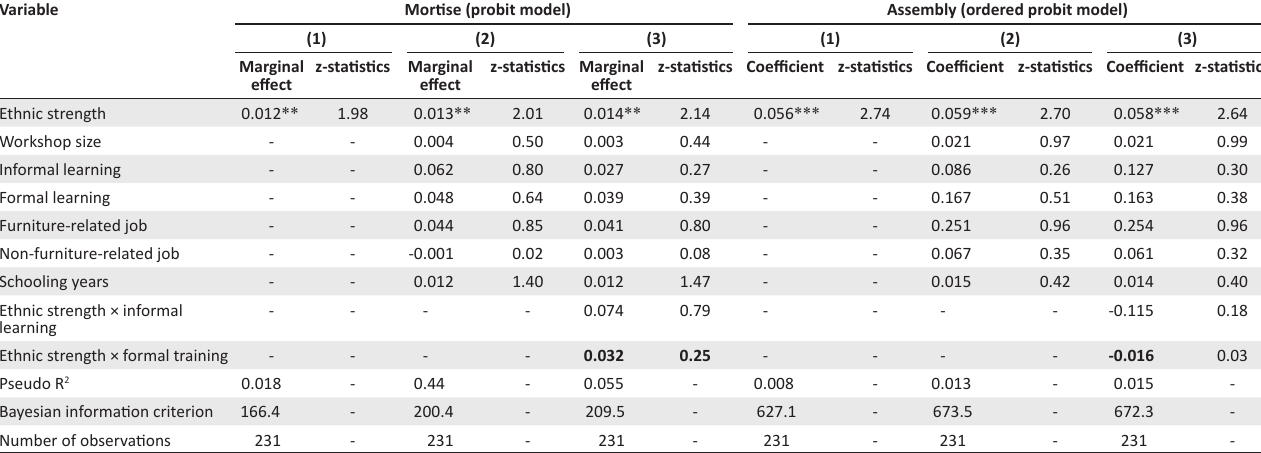
TABLE 5: Assembly skill and ethnic strength.